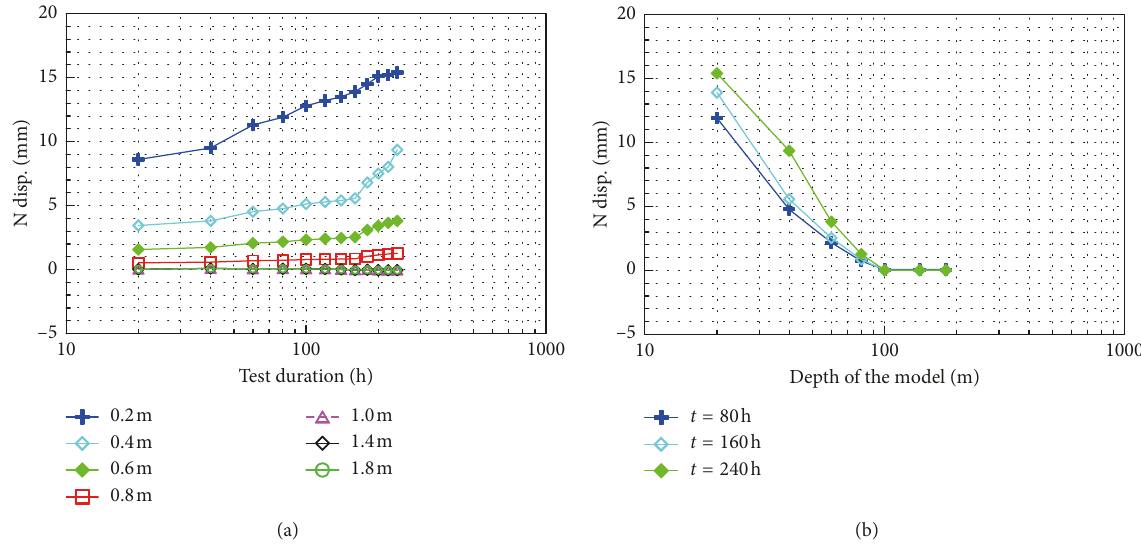
Figure 11: Layered deformation of foundation. (a) N disp. over time. (b) N disp. over the depth of the